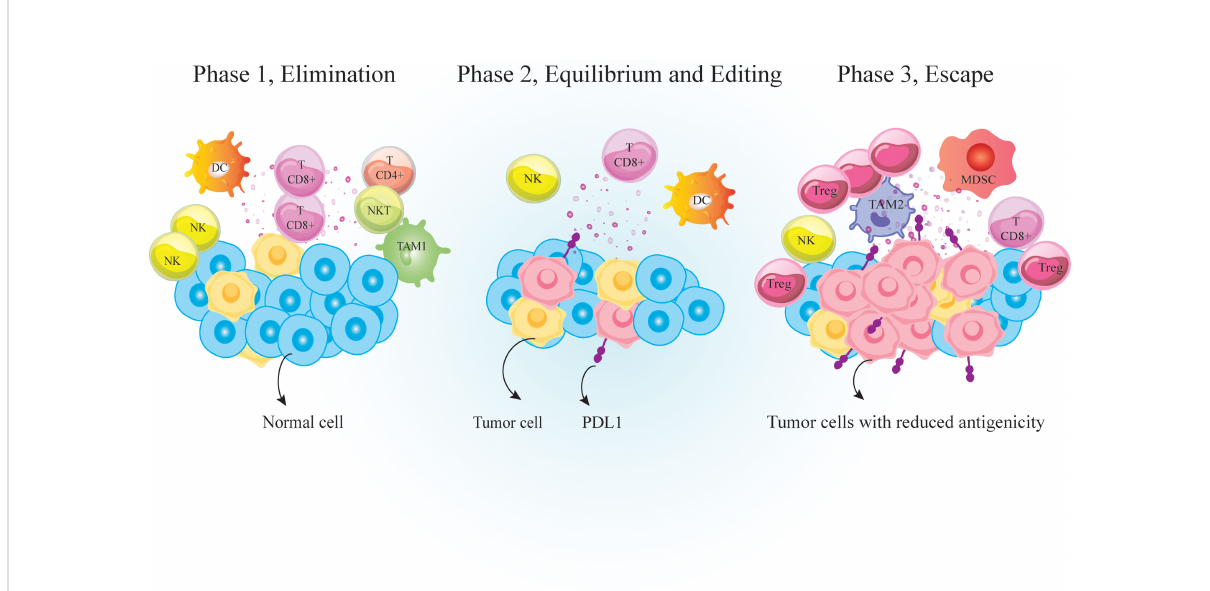
FIGURE 1 Immunosurveilance and cancer immunoediting. Immunosurveillance is a monitoring process by which cells of the immune system detect and destroy virally infected or malignant cells. It is consisted of three major phases; 1. Elimination phase that eradicate neoplastically transformed cells; 2. Equilibrium phase that occurs upon incomplete eradication of malignant cells so a temporary state of equilibrium develops between the growing tumor and the immune cells; And 3. Escape phase during which variants of tumor cells resist, avoid or suppress the anti-tumor activity of the host immune cells to the point that the immune system is no longer able to restrain tumor growth. PD-1, Programmed cell death 1; TCD4 + , helper T cell; TCD8 + , cytotoxic T lymphocyte, DC, dendritic cells; MDSC, myeloid-derived suppressor cell; NK, natural killer; TAM, tumor associated macrophages; Treg, regulatory